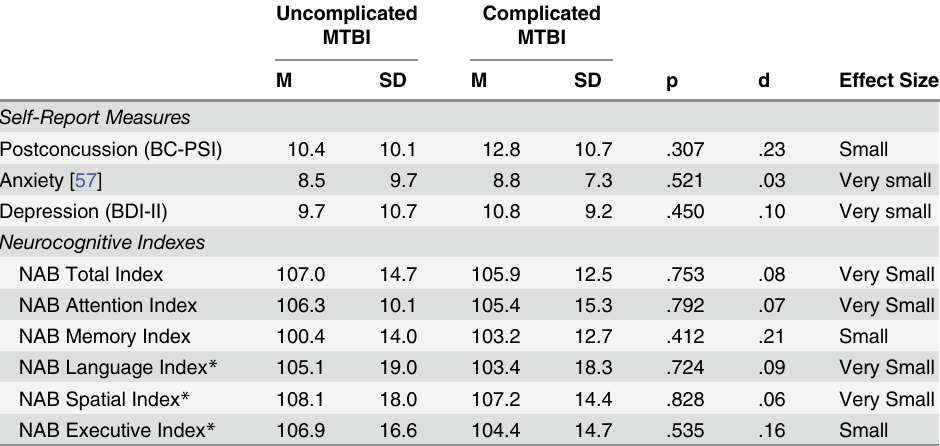
NAB Spatial Index